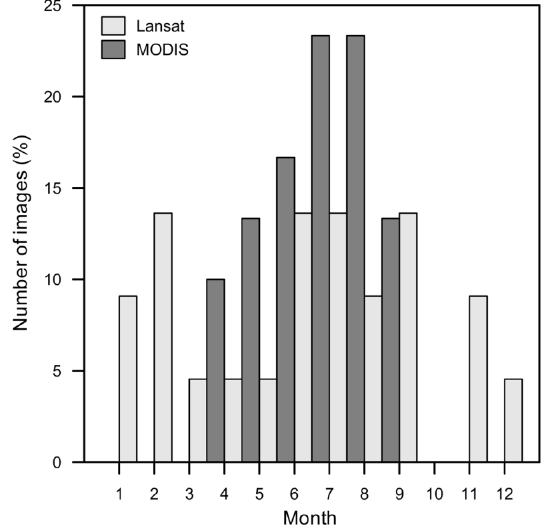
Fig. 2. Monthly temporal distribution of satellite data (clear sky and without bow tie effect: an artefact of the arrangement of sensors on the MODIS instrument, in which the scans are partially overlapping at off nadir angles) used during the period 2003-2005.